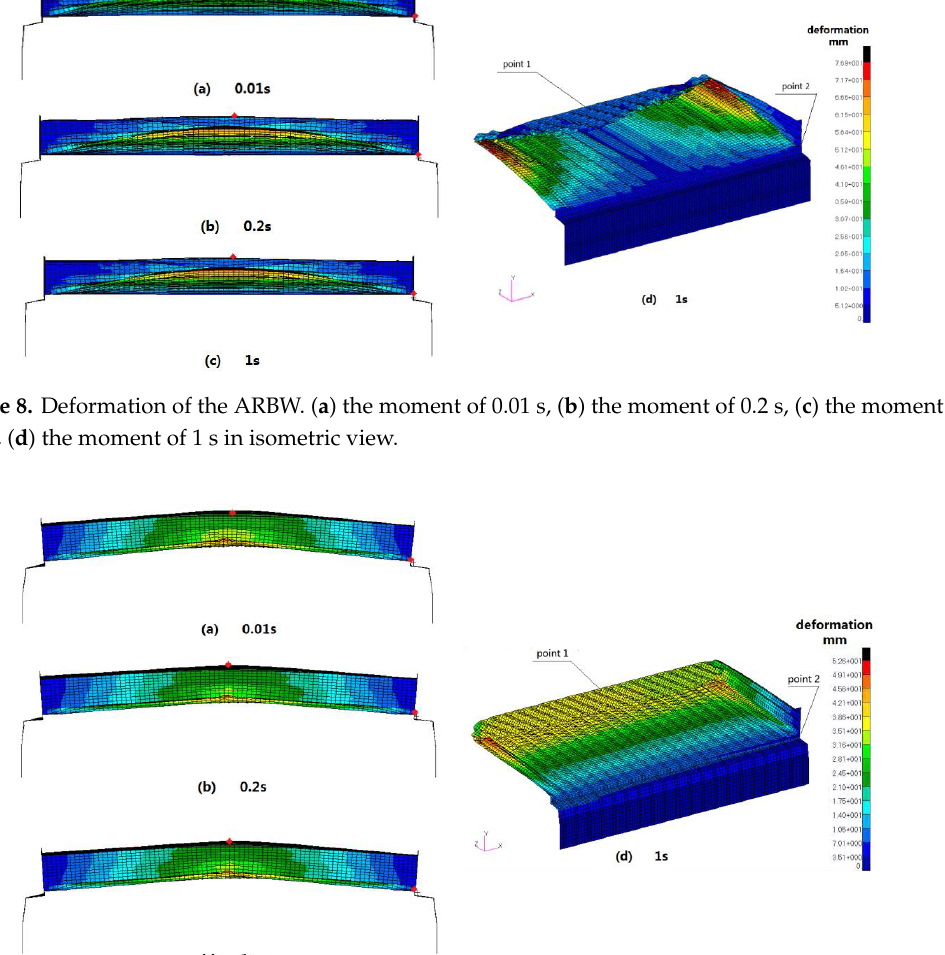
Figure 9. Deformation of the HSBW. ( a ) the moment of 0.01 s, ( b ) the moment of 0.2 s, ( c ) the moment of 1 s, ( d ) the moment of 1 s in isometric view.